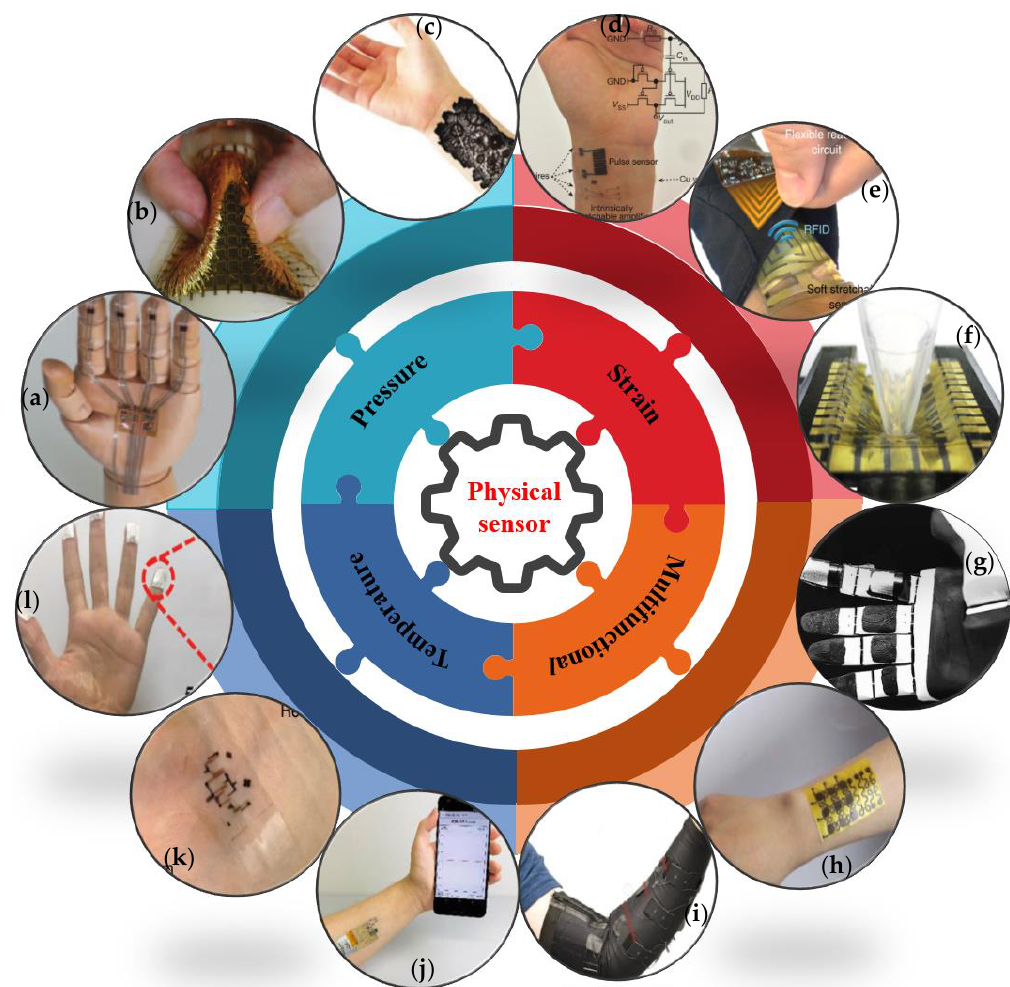
Figure 1. Representations of flexible physical sensors and typical applications: ( a ) A model hand with pressure sensor on the fingertips (Reprinted with permission from ref. [31]. Copyright 2015, American Association for the Advancement of